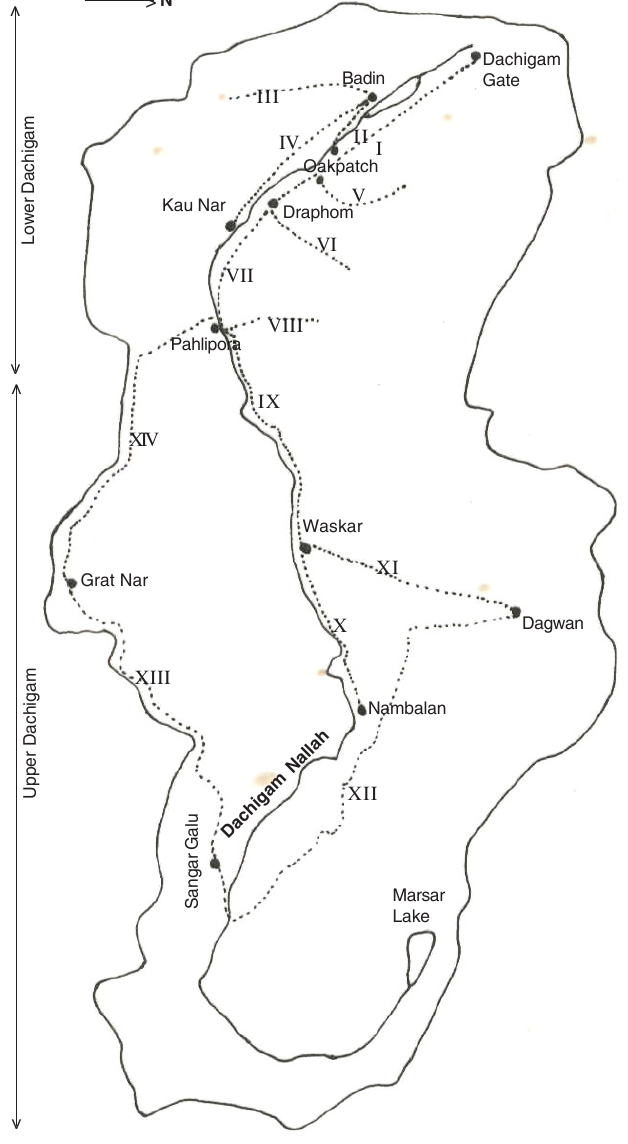
Figure 1. Dachigam National Park (Scats collected along transects